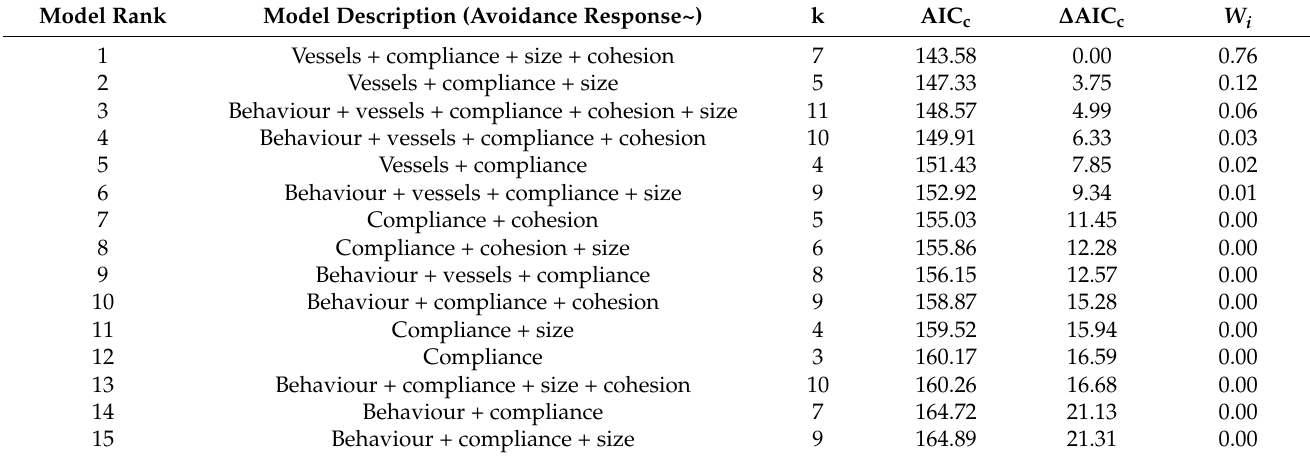
Table 3. Model selection for the generalized linear mixed-effects models (GLMMs) used to describe the response of the dolphin groups (avoidance) to the presence of vessels in the observation area (50 to 300 m around the group). The tilde (~) is read as “in function